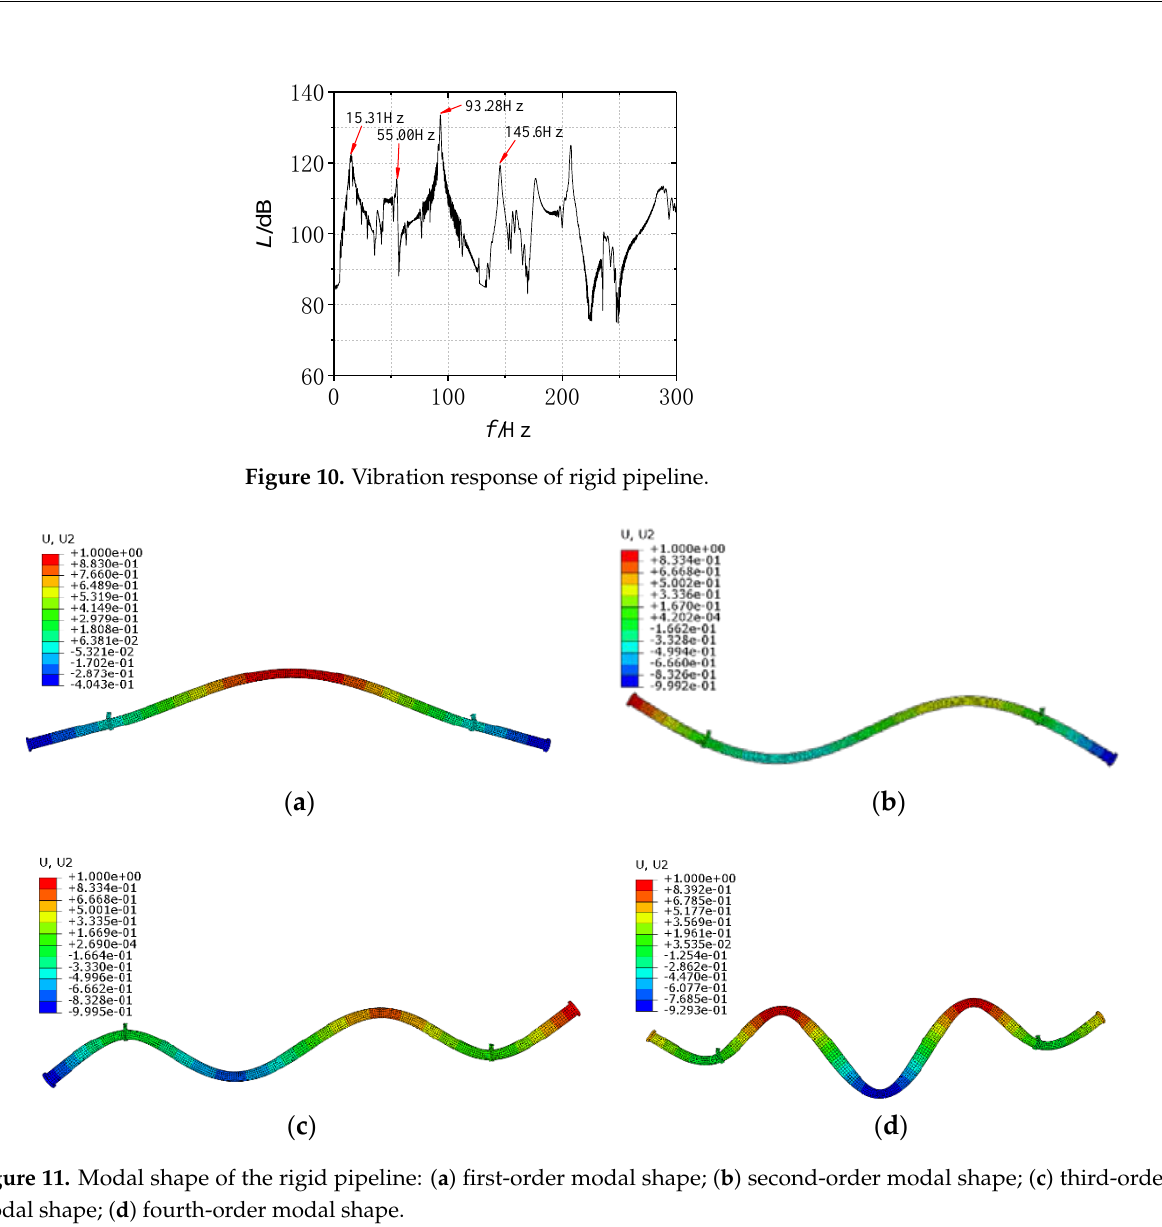
Figure 12. Vibration response of rigid pipeline. According to the pipeline vibration response collected by each accelerometer, the po- sition with the maximum vibration response of the pipeline was obtained. Combined with the FEMA modal shape obtained in Figure 11 it was decided to apply the LCDS from the middle to the end of the pipeline. Additionally, the influence of the cladding position was verified by changing the cladding length in the test. In order to explore the influence of different ambient temperatures, different coated layers and different coated length on the vibration attenuation effect of the LCDS, the ex- periment was divided into three groups, as shown in Table 2. Table 2. Three groups of parameters of long coated damping structure. Layers